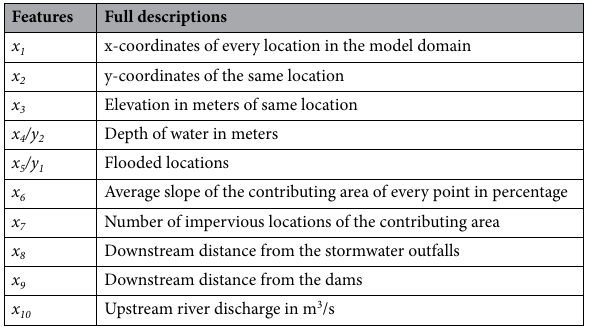
Table 1. Full descriptions of the predictors and target variables used to train/test the ML classifiers and DNN regression model.